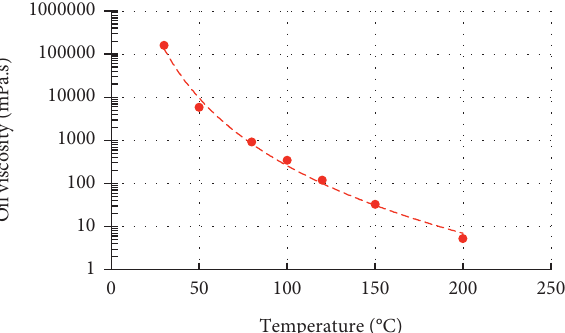
Figure 1: Crude oil viscosity-temperature